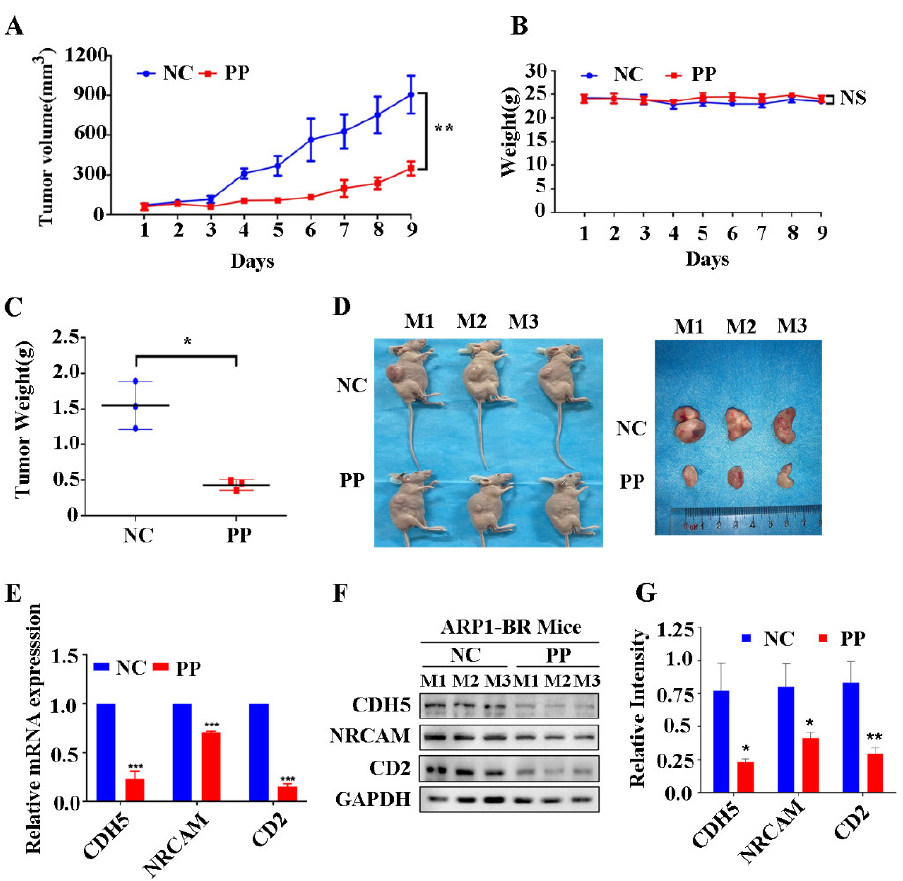
Figure 6. Periplocin attenuates tumor growth in vivo in BTZ-resistant xenograft mouse model of MM and suppresses CAMs. ( A ) Daily changes in tumor volume of ARP1-BR-inoculated mice after PP treatment, compared with the control untreated group. ( B ) Daily changes in weight of ARP1-BR bearing mice after PP treatment. ( C ) The changes in weight of tumor created by ARP1-BR bearing mice after PP treatment. ( D ) The photograph of mice bearing tumor of ARP1-BR cells after PP treatment before dissection (right side). The photograph of removed tumor from ARP1-BR cells bearing mice after PP treatment (left). ( E ) Detection in the reduced expression level of CD2, CDH5, and NRCAM genes through qRT-PCR in tissue samples of ARP1-BR cells bearing mice after PP treatment compared with untreated mice. ( F ) Detection of reduced expression of CD2, CDH5, and NRCAM at the proteins level in tissue samples of ARP1-BR cells bearing mice after PP treatment compared with untreated mice. ( G ) Bar graph representation of the significantly reduced expres- sion of CD2, CDH5, and NRCAM at protein levels in tissue samples of ARP1-BR-cells bearing mice after PP treatment compared with untreated mice. The data is presented as the mean ±SD from three mice. The results were considered significant statistically at p < 0.05. The more significant values were demonstrated as * p < 0.05, ** p < 0.01, *** p < 0.001, and ns: not significant. 4. Discussion Over the past decade, the survival of MM patients has improved with the devel- opment of chemotherapy options in the field of myeloma treatment [4]. The well-known effective class of anti-MM drugs such as proteasome inhibitors BTZ has more significant survival and improved response rates [5,6,46]. However, MM patients are still facing major clinical issues of relapse and BTZ resistance due to the complex system of the BM, extracellular matrix, adhesion molecules, and heterogeneous genetic/epigenetic basis of MM [47,48]. The mechanism of recurrence and relapse is poorly understood in MM. However, it has been reported that the BTZ resistance capability of MM leads to recur- rence and relapse, making challenges for the effective treatment of MM [7–11,49,50]. Various factors participate in resistance to anti-MM drugs, while many studies have found that CAMs are involved in MM drug resistance [19–26]. Anyhow, BTZ resistance is